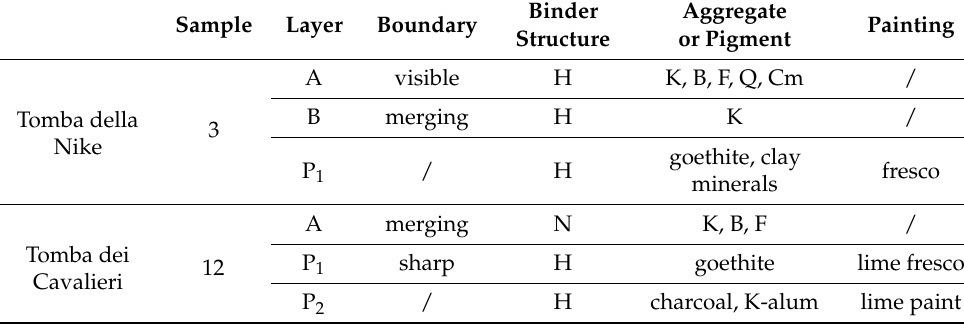
Table 1. Petrographic features of the lime plasters and paintings after POM and SEM-EDS anal- yses. Abbreviations: H = homogeneous; N = nodular; K = calcareous sand; Ks = spathic calcite; B = bioclasts; F = ferruginous lumps; Q = quartz; Cm = clay minerals. The layers are named from